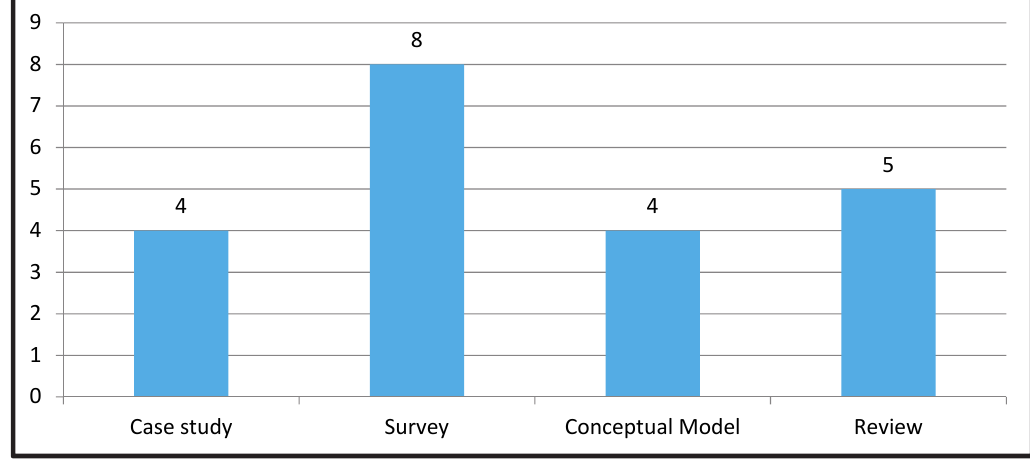
Fig. 1. Research methodologies